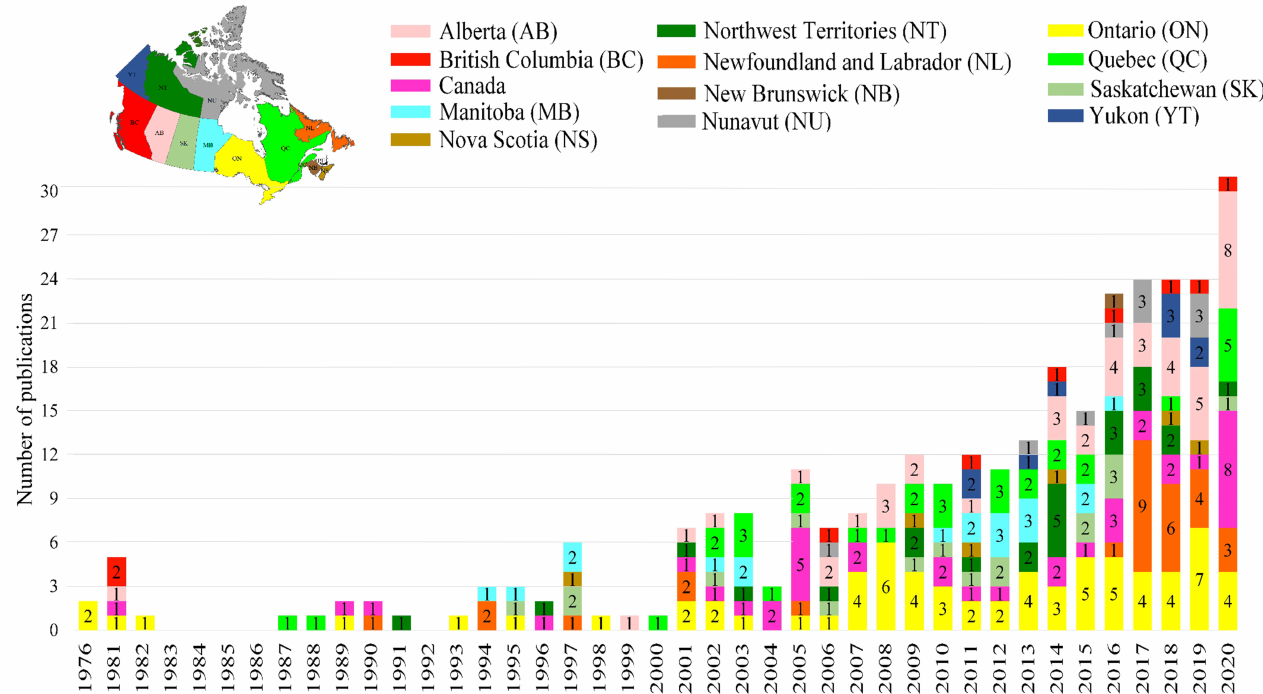
Figure 3. Schematic summary of the number and percentage of RS-based wetland publications along with a list of the key journals and the corresponding number of studies published in each for various time intervals.